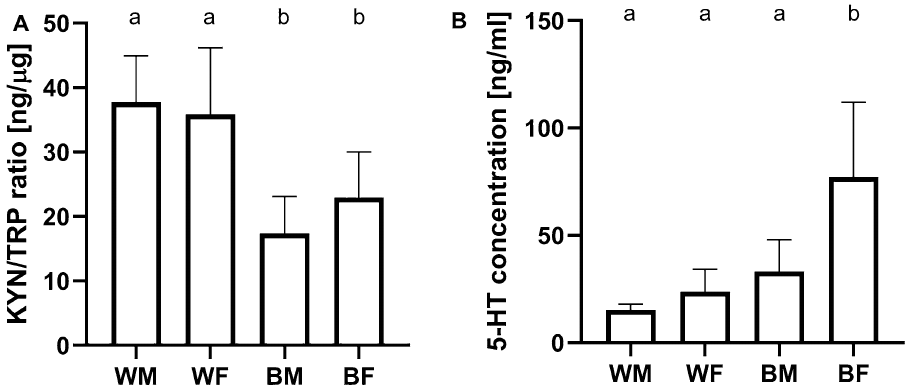
Figure 1. Average values (mean ± SD, n = 10) of ( A ) kynurenine/tryptophan ratio (ANOVA F (3, 36) = 16.23, P < 0.0001) and ( A ) serotonin concentration in hemolymph for imagos (Brown-Forsythe ANOVA 15.77 (3, 11.01) P = 0.0003). Males (M) and females (F) from white (W) and black-eyed (B) strain. Different letters denote groups differing significantly; ( A ) Tukey’s multiple comparisons test, P < 0.05 ( B ) Dunnett’s T3 multiple comparisons test, P <